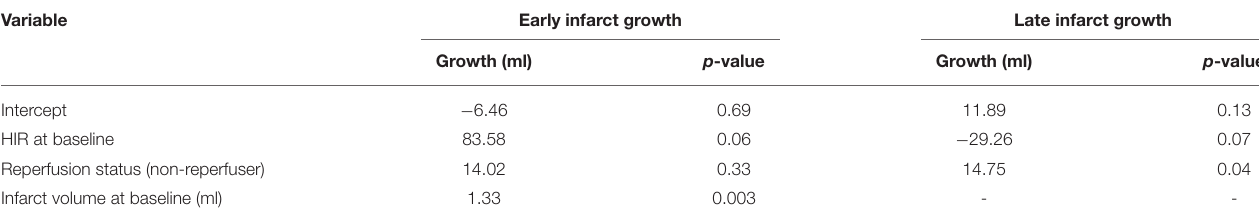
TABLE 2 | Multiple linear regression analysis for infarct growth ( n = 66).